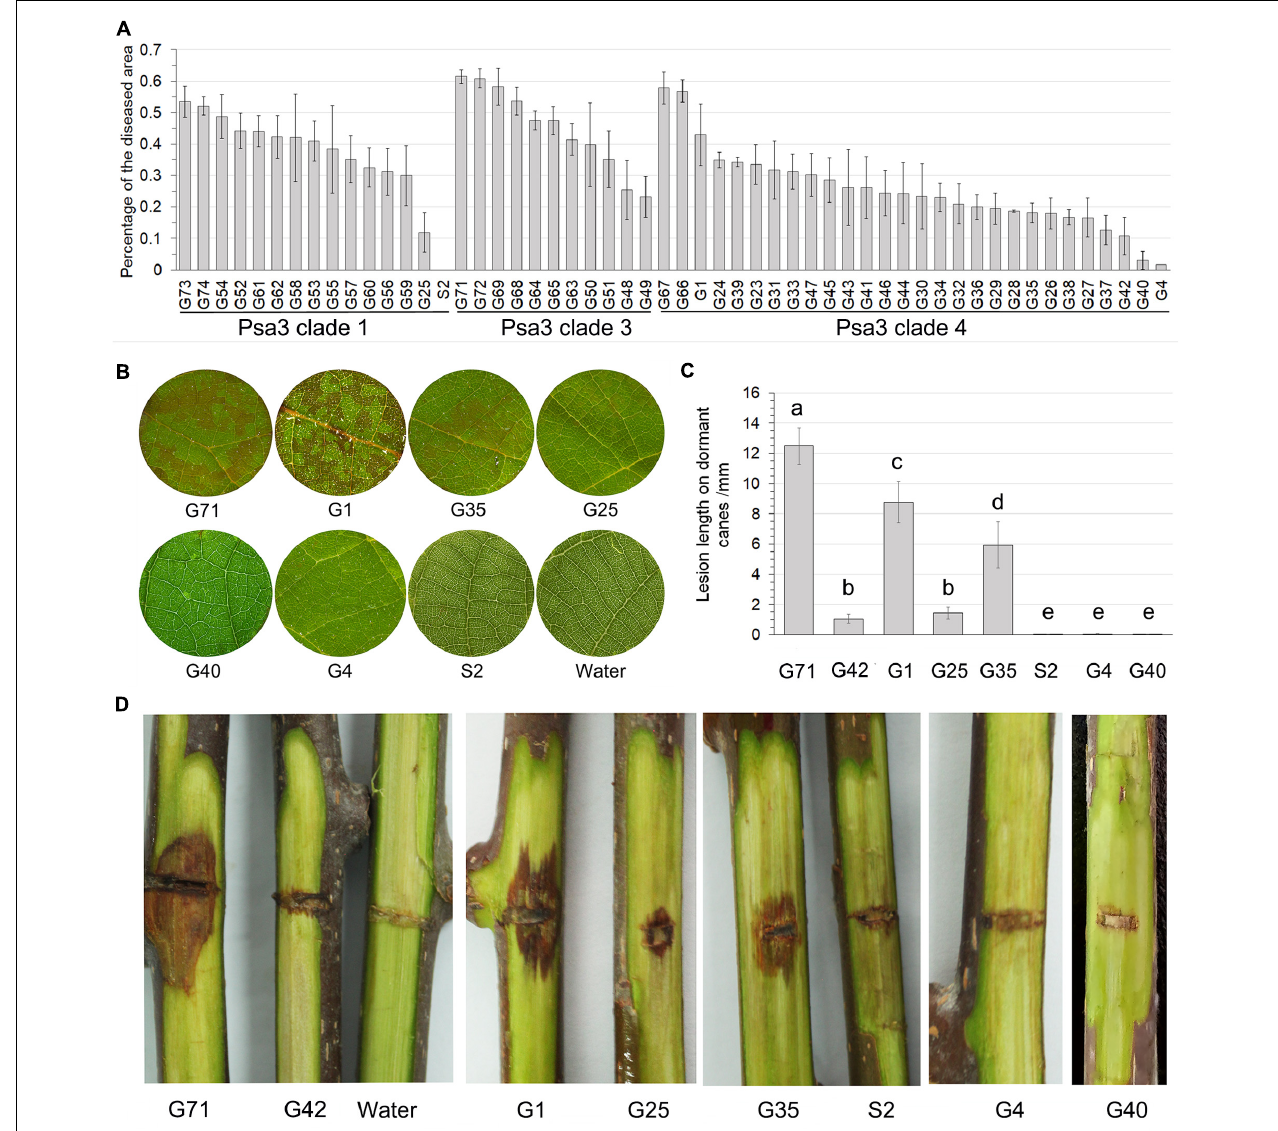
FIGURE 3 | Non-pathogenic and very low-virulent isolates within Pseudomonas syringae pv. actinidiae biovar 3 (Psa3) were identified. (A) Diverse pathogenicity of the Psa3 isolates. The pathogenicity patterns of 54 Psa3 isolates from Guizhou Province were determined using a vacuum-infiltration inoculation method on leaf discs of Actinidia chinensis var. chinensis “Hongyang.” (B) Representative photographs of the non-pathogenic and very low-virulent isolates on kiwifruit leaf discs. (C,D) The pathogenicity of the non-pathogenic and very low-virulent isolates were confirmed by wound inoculation on detached dormant woody canes of kiwifruit cultivar “Hongyang.” Values are means ± standard deviations (SDs). The experiments were repeated three times with similar